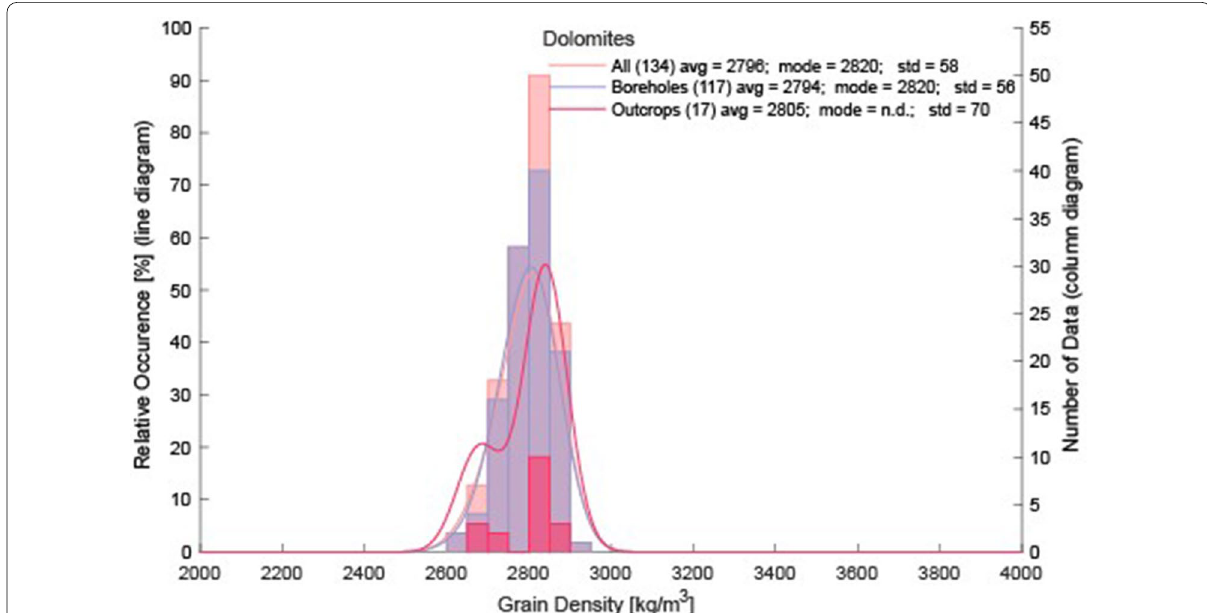
Fig. 8 Density values distribution for dolomites. Number in parenthesis represent the total number of data. See Fig. 6 for explanation of curves and histograms. In this case, the graphs justify our choice to merge the surface data with data at depth (boreholes). The mode for outcrops and borehole data though is quite different. The difference between mode and average in the outcrop data is also significant, indicating a large uncertainty, linked to the low number of data available (18). Averages are in both cases coincident. The total data population has been used to attribute a density value of 2796 kg/m 3 and a standard deviation of 58 kg/m 3 for the